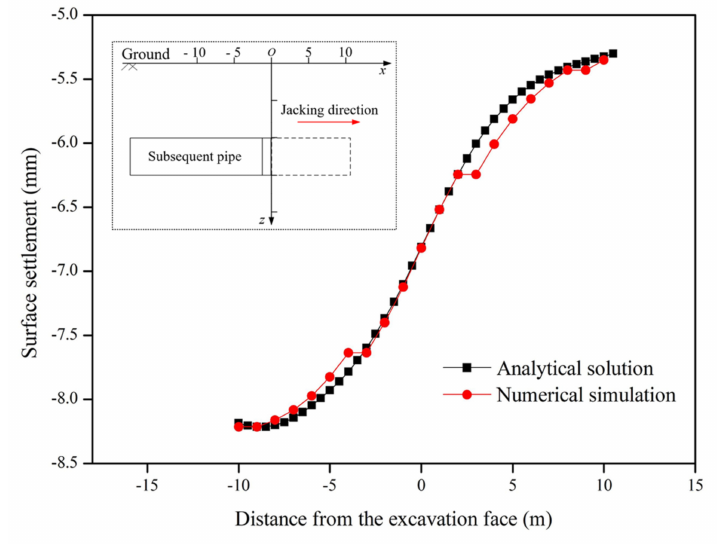
Figure 11. Curves of longitudinal ground surface